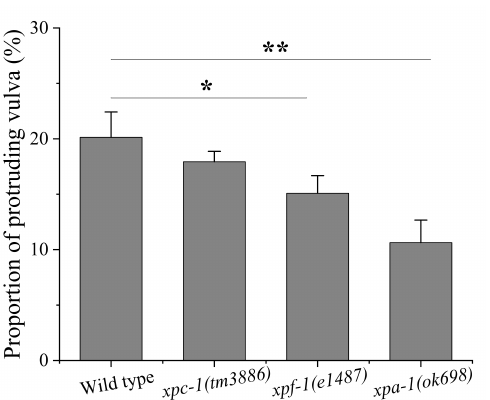
Figure A4. Radiosensitivity of the vulva of worms impaired in the NER pathway. Results are means ± SD ( n ≥ 3, t -test, * p < 0.05 and ** p <